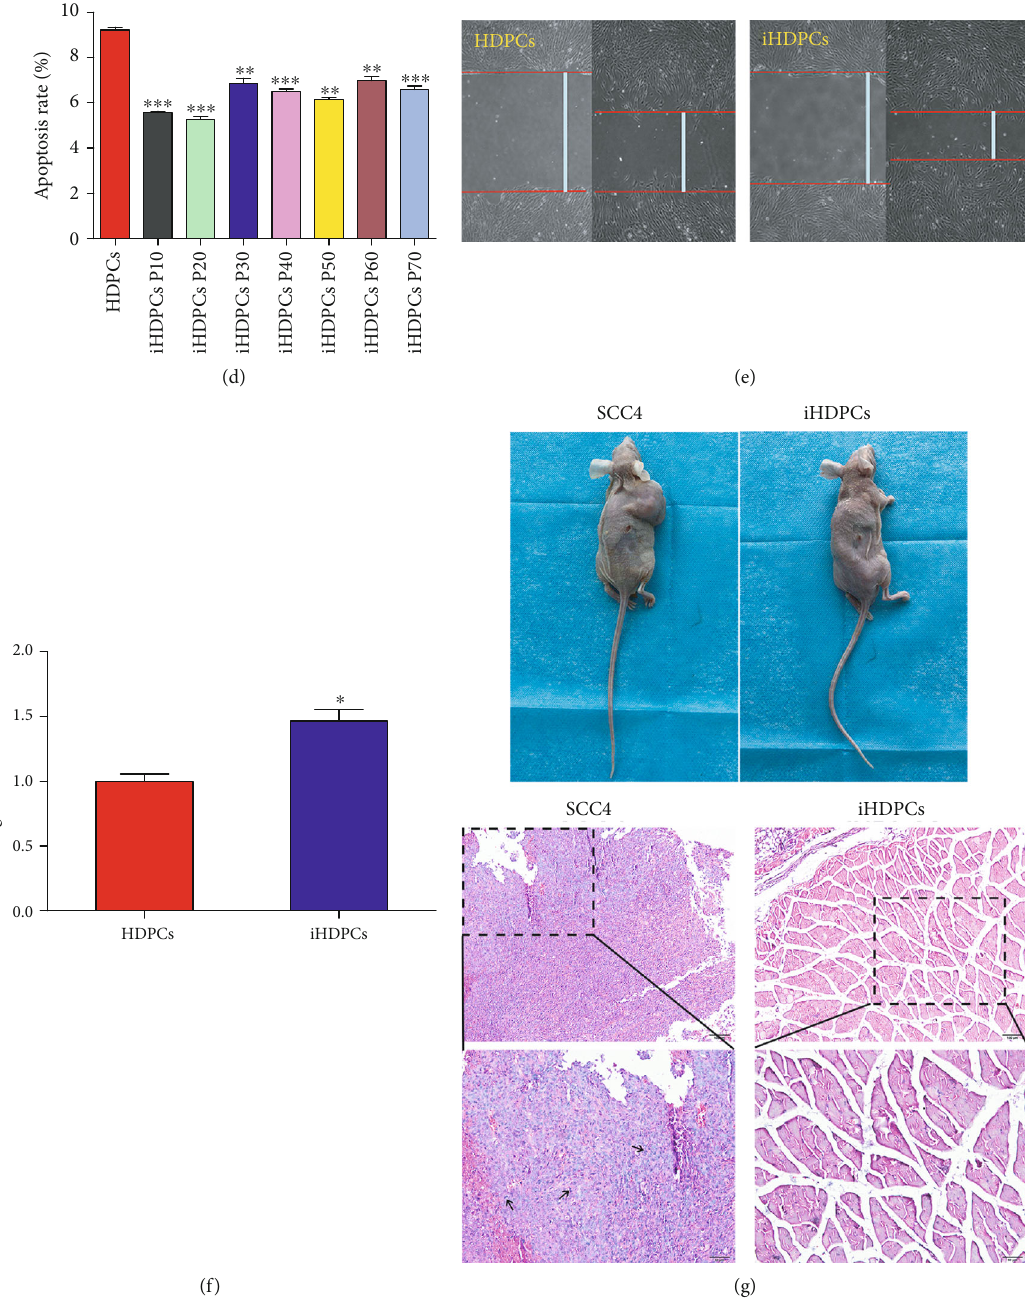
Figure 3: Biological behavior changes of iHDPCs. (a) Flow cytometric analysis showed the cell cycle distribution of HDPCs and iHDPCs. (b) Cell cycle analysis by fl ow cytometry showed increased G2-M phase fractions in the iHDPCs while the cell cycle distribution of iHDPCs was not a ff ected by passaging ( ∗∗∗ P < 0 : 001 ). (c) Flow cytometric analysis showed the levels of apoptosis in HDPCs and iHDPCs. (d) The percentage of apoptotic cells among iHDPCs was signi fi cantly lower than that among HDPCs and was not a ff ected by passaging ( ∗∗ P < 0 : 01 , ∗∗∗ P < 0 : 001 ). (e and f) The migration rates of HDPCs and iHDPCs were quanti fi ed using the wound healing assay ( ∗ P < 0 : 05 ). (g) The nude mouse tumorigenicity assay was used to test the oncogenicity of iHDPCs, with SCC-4 used as the positive